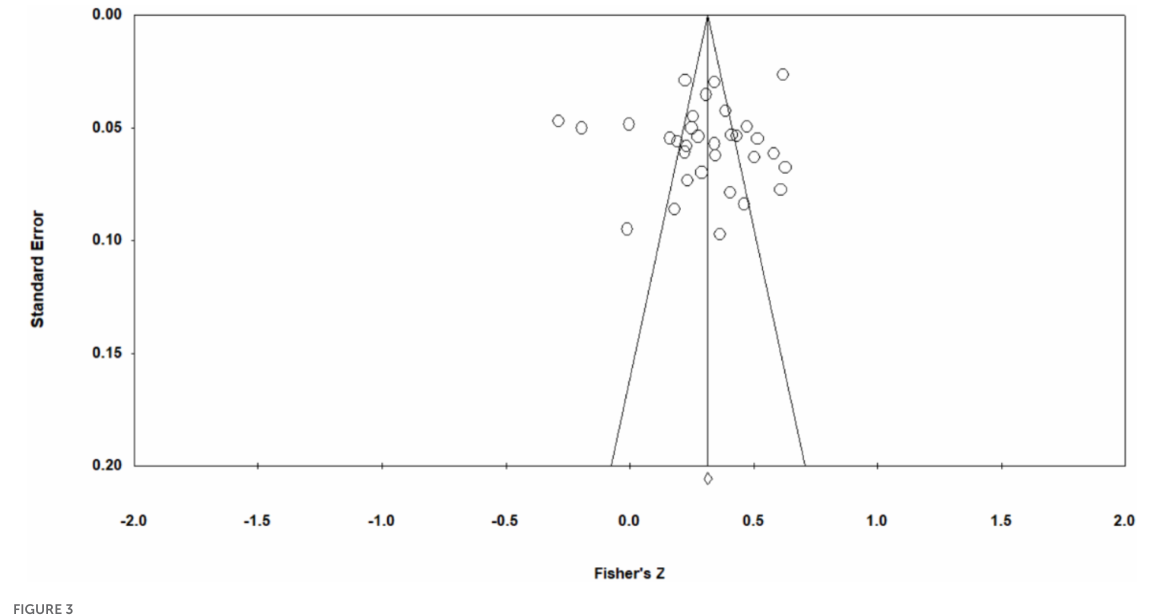
FIGURE3 Funnel Plot of Standard Error by Fisher’s